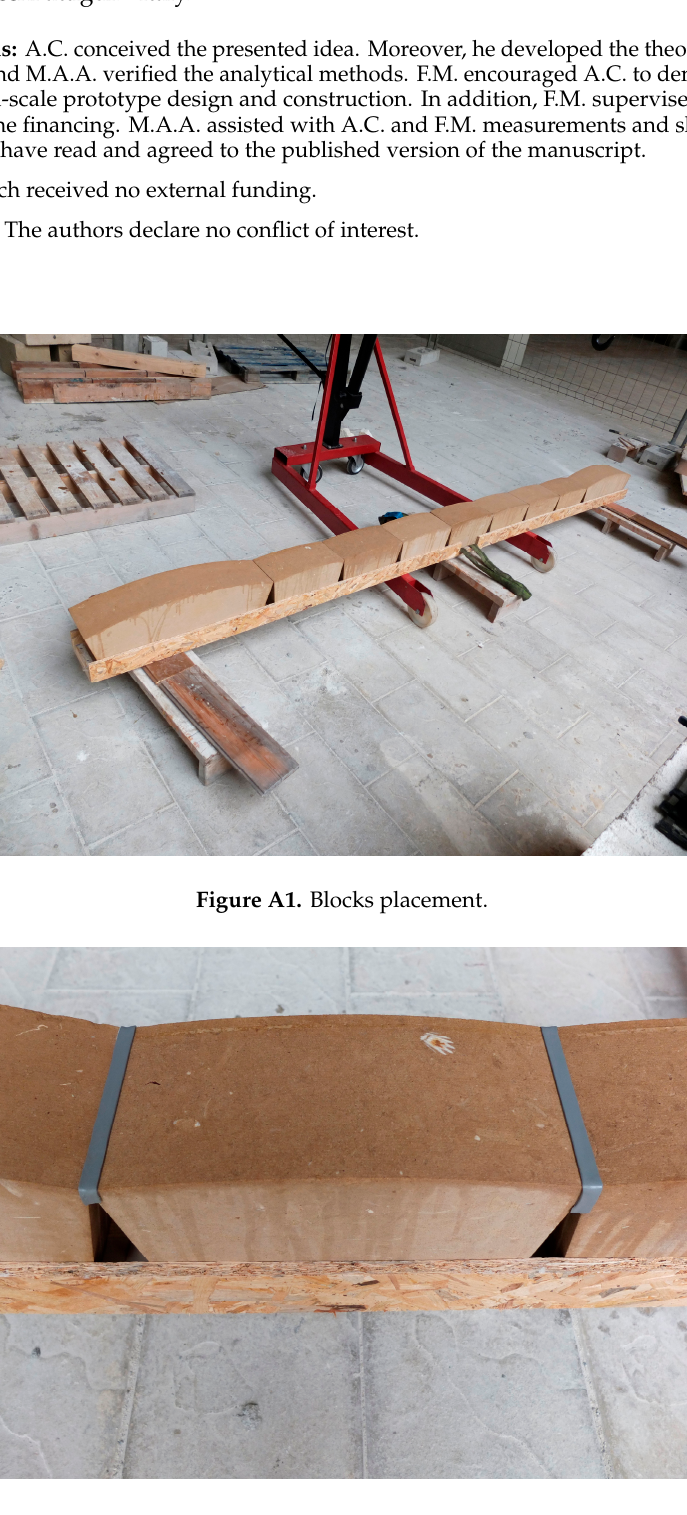
Figure A2. Detail of the butyl tape .